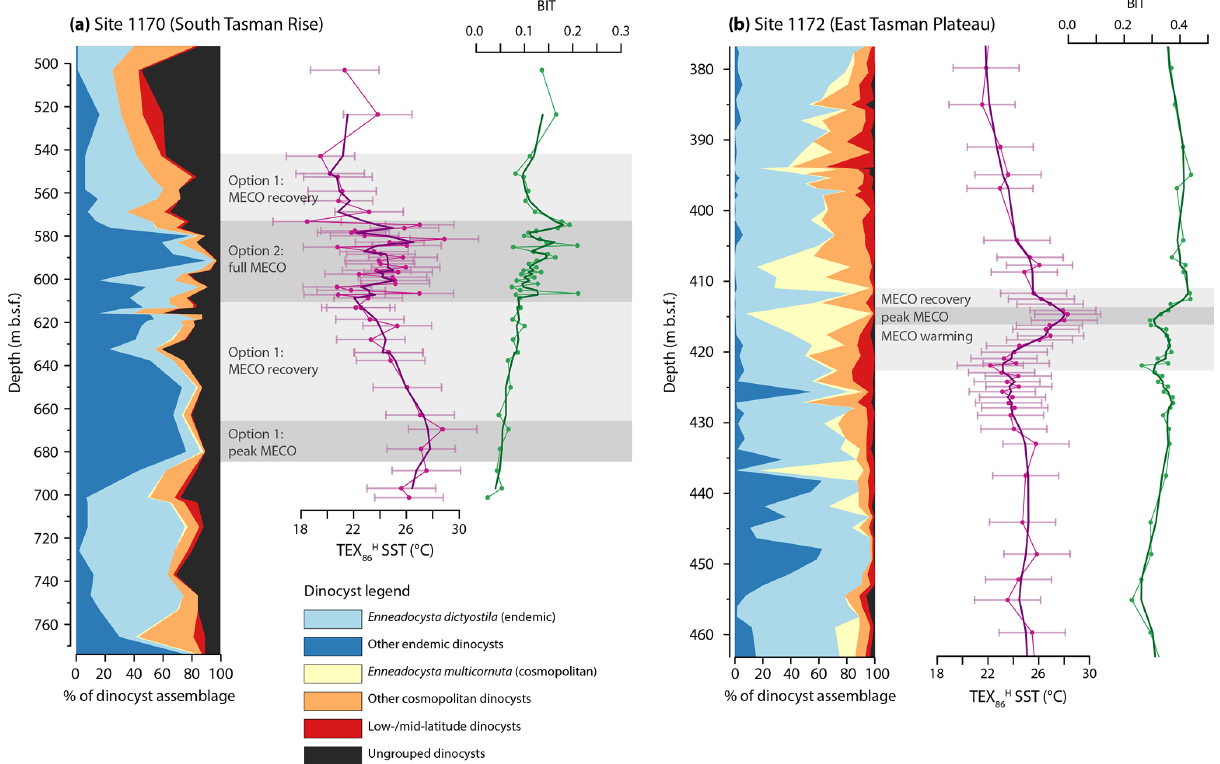
Figure 3. Dinocyst and temperature data from ODP Site 1170 and Site 1172. (a) Left: cumulative silhouette plot of relative abundances of dinocyst biogeographic groups at Site 1170. Especially for the younger part of the 1170 record, a high proportion of specimens of the genus Deflandrea could not be identified to the species level, causing the high abundance of the “others” group. Middle: TEX H in pink, with a five-point moving average in purple. Error bars are combined calibration and analytical error (1 SD) ( ± 2 . 6 ◦ C). Right: BIT in green, with a five-point moving average in dark green, plotted against depth in meters below seafloor on the vertical axis. Gray horizontal bars visualize the two different options for extent of the MECO, as presented in Sect. 4.1.3. (b) Same as (a) but for Site 1172. Data are from Bijl et al. (2010,